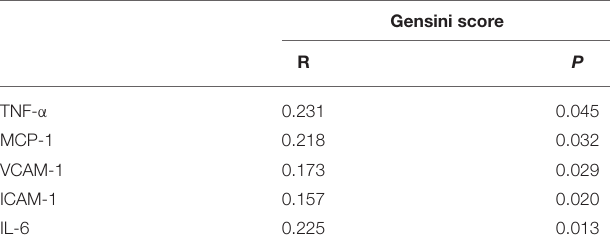
TABLE 4 | Correlation analysis of the Gensini score and TNF- α , MCP-1, VCAM-1, ICAM-1, and